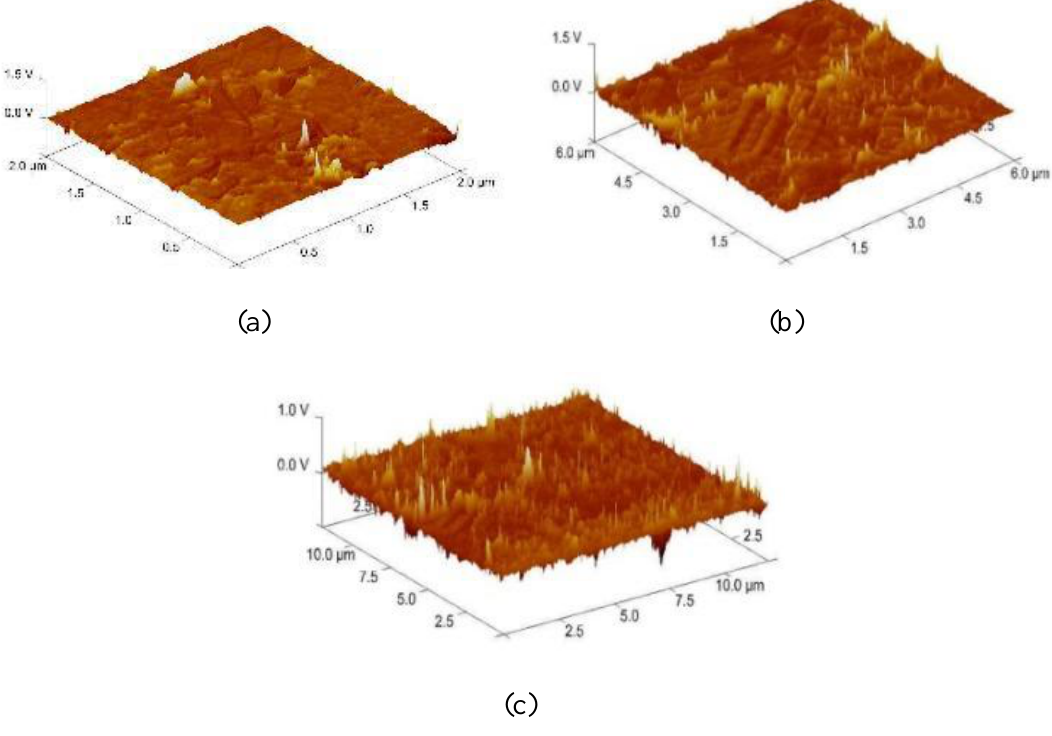
Figure 9. Three dimensional Friction images for different scan sizes for GC435 coated carbide inserts of (a) 2 μm; (b) 6 μm and (c) 12